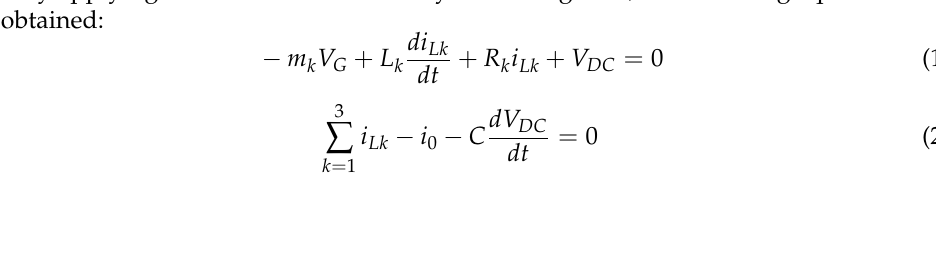
Figure 2. Equivalent block diagram of the three-phase power electronic converter.